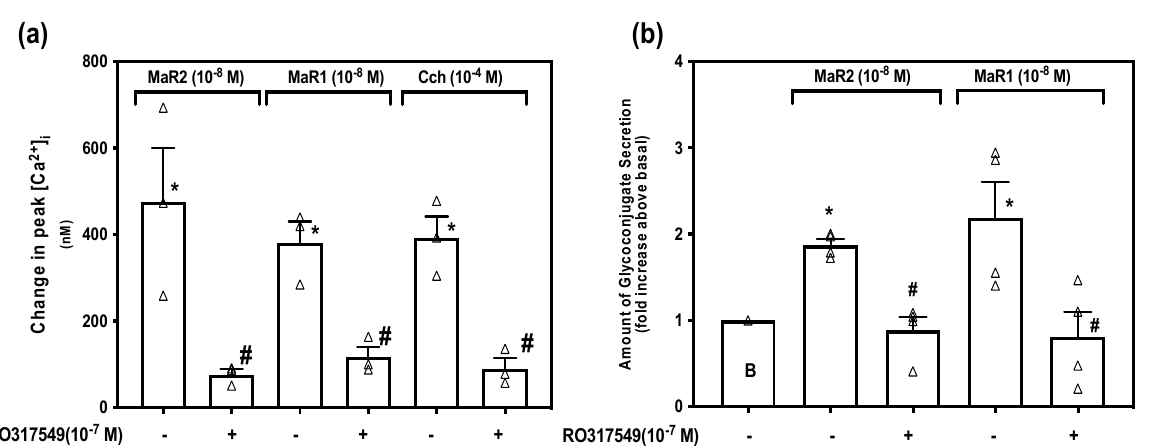
Figure 7. Maresin 2 increases [Ca 2+ ] i and stimulates secretion by activation of protein kinase C (PKC). Goblet cells were incubated with RO317549 (10 − 7 M) for 30 min, then stimulated with MaR2 (10 − 8 M) or the positive controls MaR1 (10 − 8 M) or Cch (10 − 4 M) and then [Ca 2+ ] i and secretion were measured. ( a ) shows change in peak [Ca 2+ ] i , while ( b ) shows -fold increase in glycoconjugate secretion. Data are mean ± SEM of three ( a ) and four ( b ) experiments. White triangles indicate individual data points. * shows significance above basal. # shows significance between agonist and inhibitor then agonist.